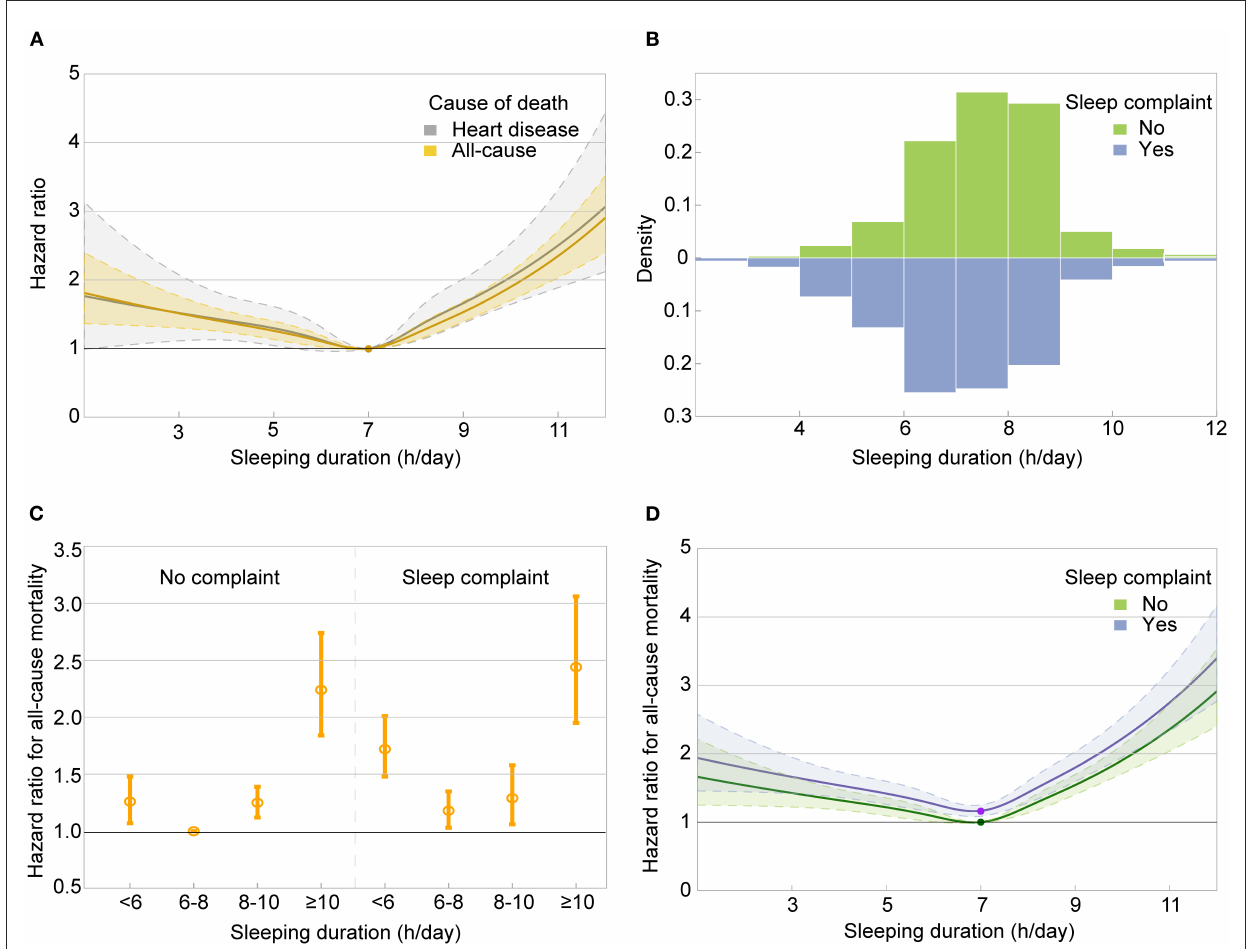
FIGURE2 Relationship between sleep duration, sleep complaints, and mortality. (A) Dose–response association between sleep duration and risk of all-cause and heart disease mortality. (B) The distribution of sleep duration by sleep complaints. (C) The hazard ratios of all-cause mortality among eight combined groups of sleep duration and sleep complaints in the joint analysis. (D) Dose–response association between sleep duration and risk of all-cause mortality by sleep complaints. Associations in panels (A, D) were examined by multivariable Cox regression models based on restricted cubic splines. The solid line represents estimates of hazard ratios and the dashed line represents 95% CIs. P -values for non-linear association were < 0.001 in both panels. Risk estimates in panels (A, C, D) were adjusted for baseline age, sex, education level, smoking status, leisure time moderate-to-vigorous physical activity level, body mass index, history of diabetes, and